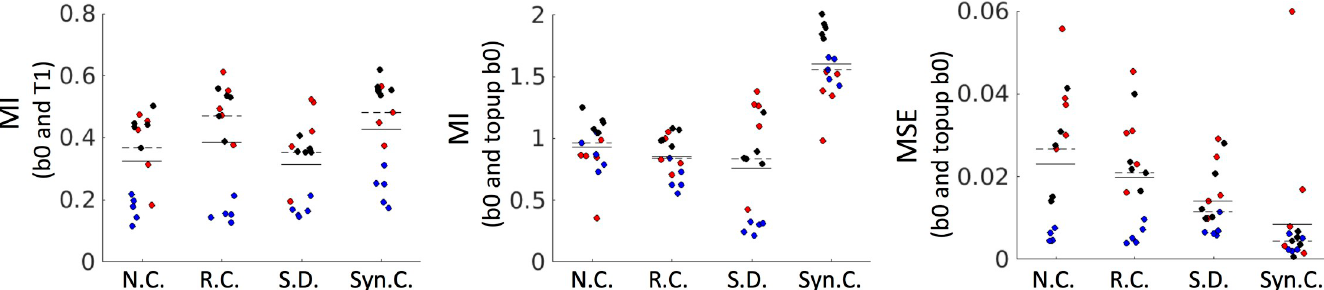
Fig 7. Validation of geometry and contrast after distortion correction. Top: MI of the non-corrected (N.C), registration corrected (R.C.), legacy synthetic-distortion (S.D) and proposed synthetic correction (Syn.C.) b0 images with the structural T1 image. A higher value suggests a geometry more similar to the undistorted T1. MIddle: MI of the N.C, R.C., S.D, and Syn.C. b0 with state-of-the art topup distortion correction results. A higher value indicates geometry/contrast more similar to the goldstandard. Bottom: MSE of the N.C., R.C., S.D, and Syn.C., b0 with state-of-the art topup distortion correction results. A lower value indicates structure and image intensities more similar to the topup results. For both, solid and dashed lines indicate mean and median values, respectively. Each contains 15 datapoints, from 5 HCP subjects (blue), 5 Vanderbilt subjects (black), and 5 BLSA subjects (red).